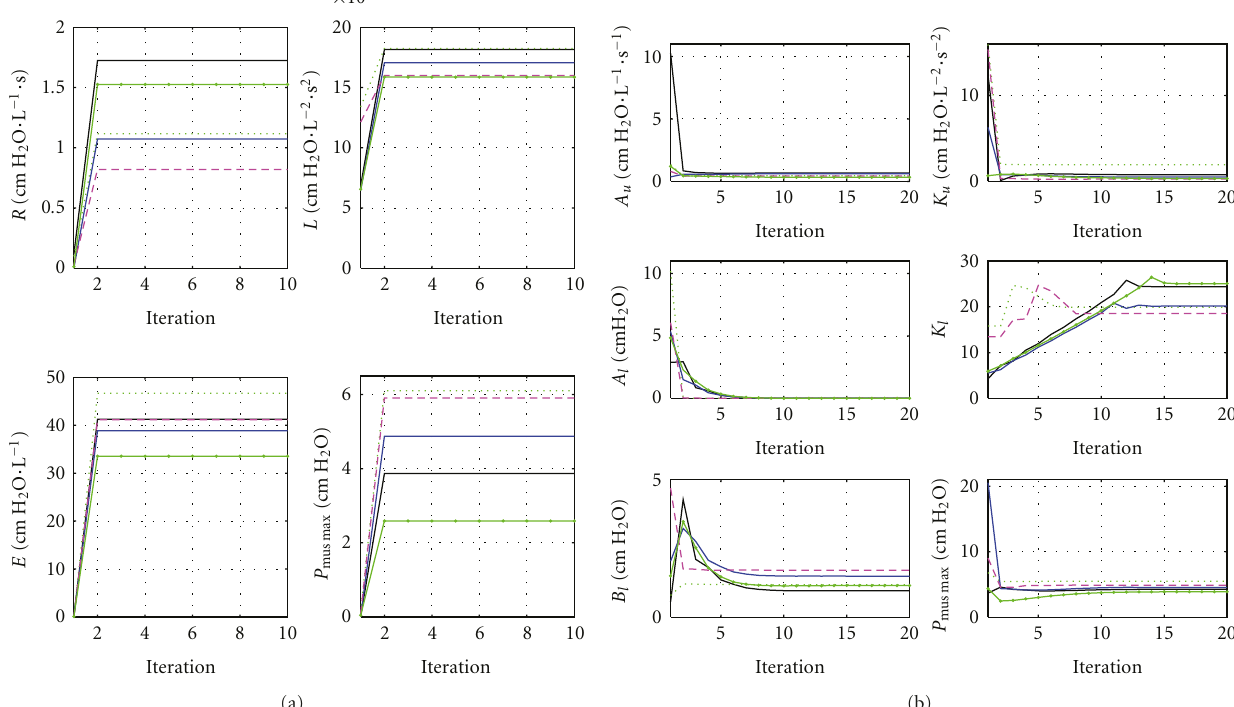
system (National Instrument DAQCard-6036E ADC-16bit) and stored into the computer for signal